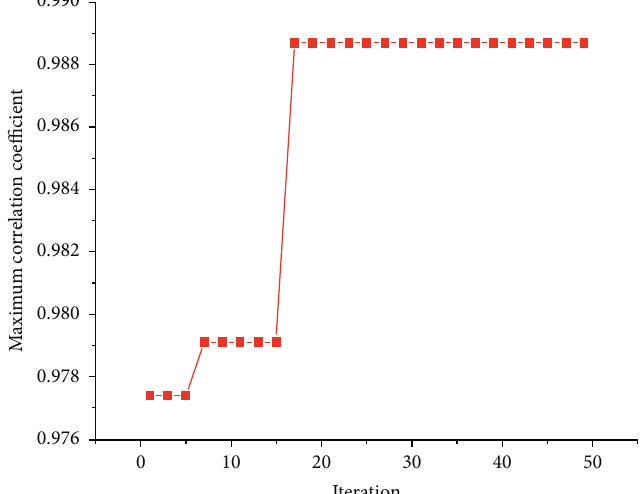
Figure 12: Update of the maximum correlation coefficient with GA iteration.